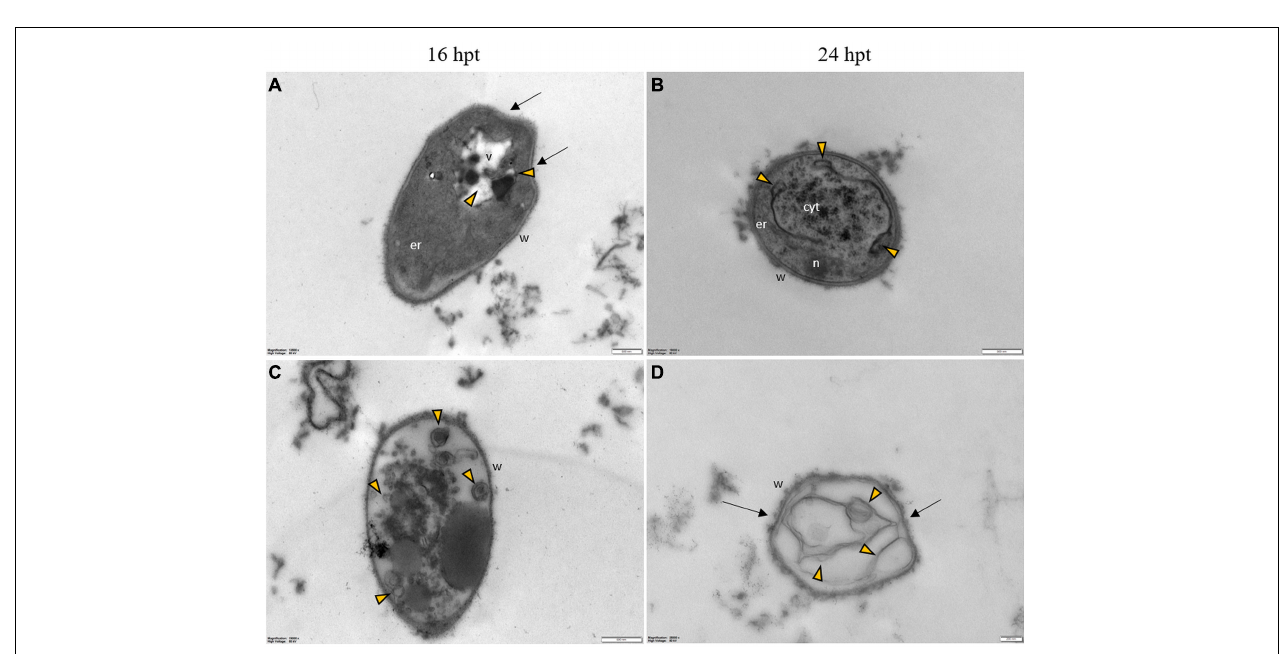
FIGURE 10 | Representative TEM micrographs of Pyricularia oryzae hyphae treated with Pep 4Rink 25 µ M and observed at 16 (A,C) or 24 hpt (B,D) . Hyphae show vacuoles containing membranous structures ( A,B,D , green arrowheads) and vesicles ( A,B,D , yellow arrowheads); the wall is distorted (arrows) and disrupted in some points ( C,D , asterisk). Cyt: cytoplasm; er: endoplasmic reticulum; m: mitochondrion; n: nucleus; v: vacuole, w: wall. Magnification bars correspond to 500 nm.